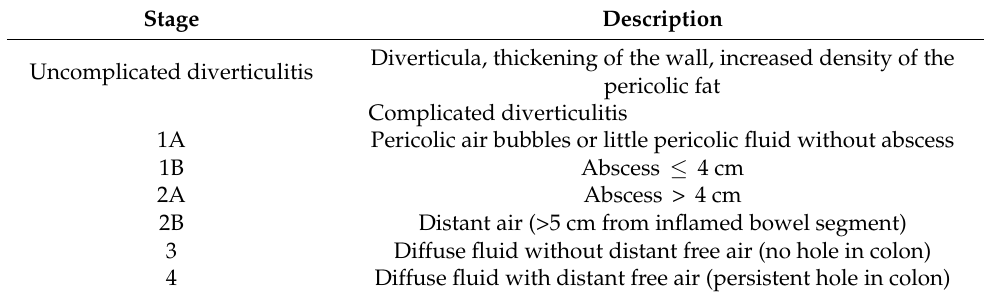
Table 1. 2015 WSES driven classification of